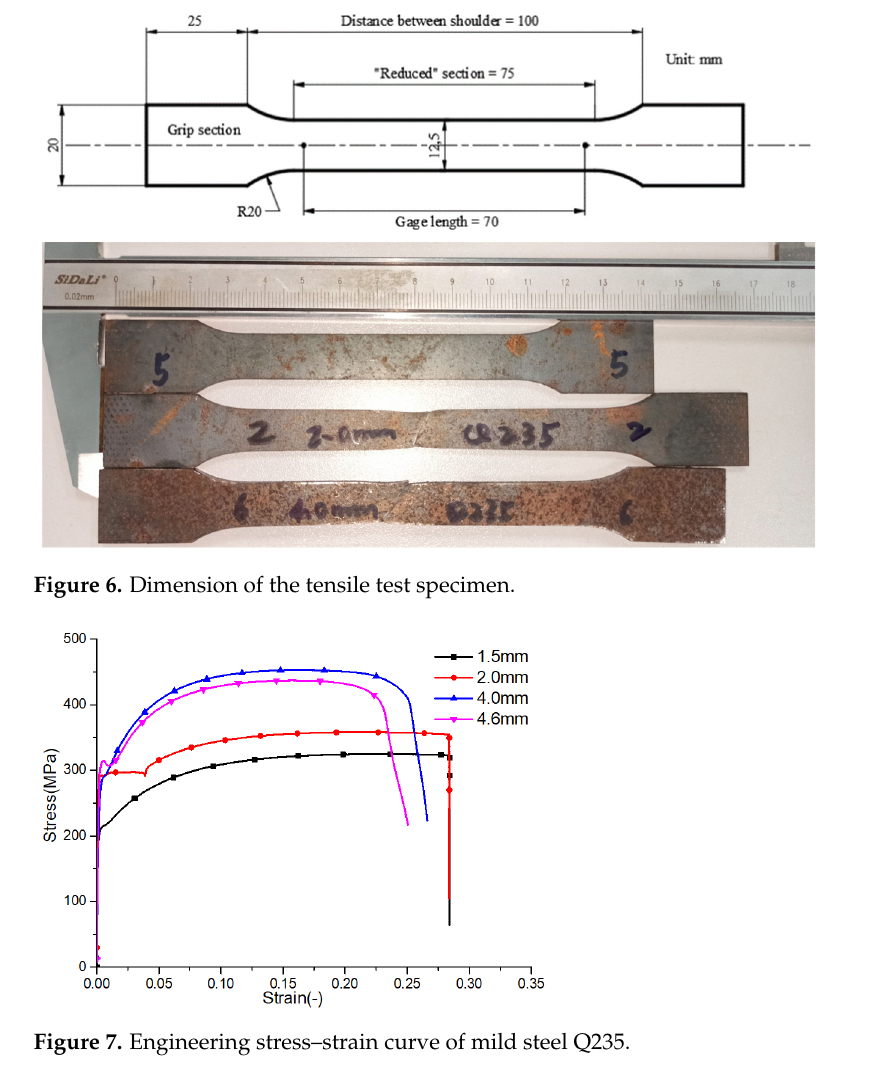
Figure 7. Engineering stress–strain curve of mild steel Q235. Table 2. Mechanical properties of